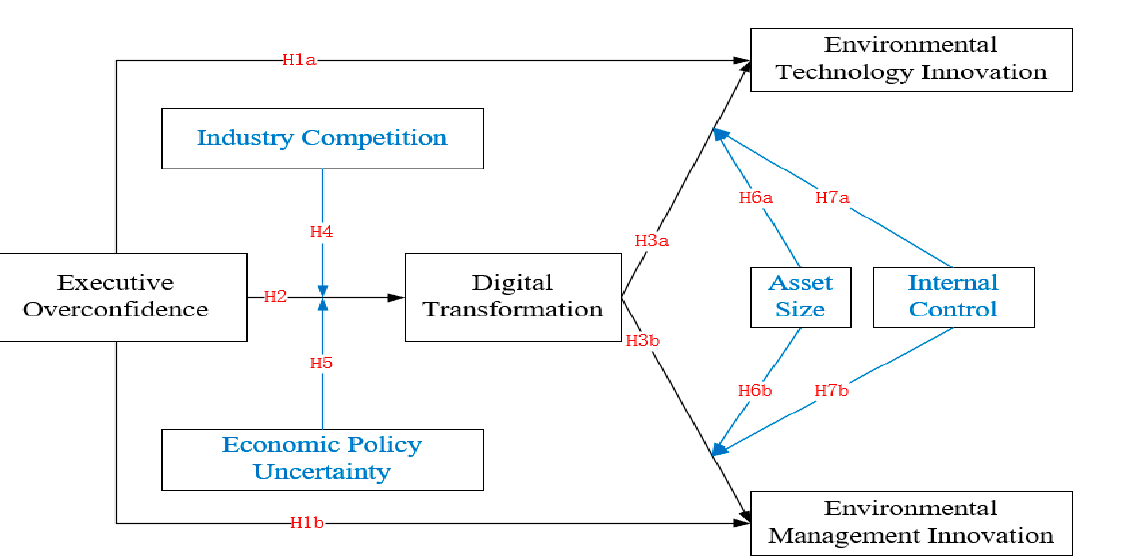
Figure 1. Research